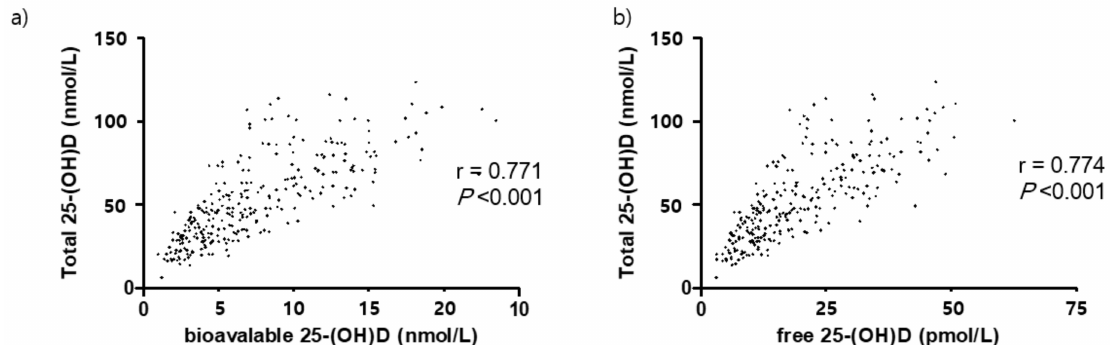
Figure 4. Correlation between total, bioavailable, and free 25(OH)D in 279 participants. ( a ) Bioavailable 25-(OH)D, ( b ) free